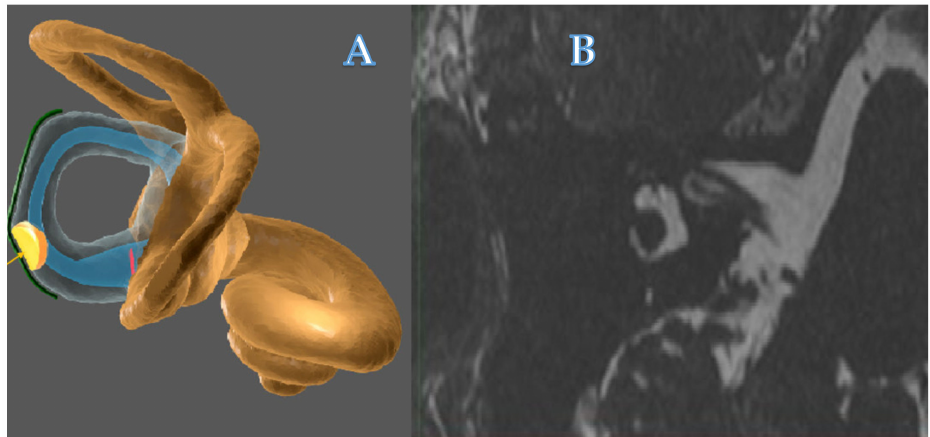
Figure 1. ( A ) Conceptual imaging of HSCC bone plugging. ( B ) MRI T2 picture of postsurgical state with interrupted HSCC. Right